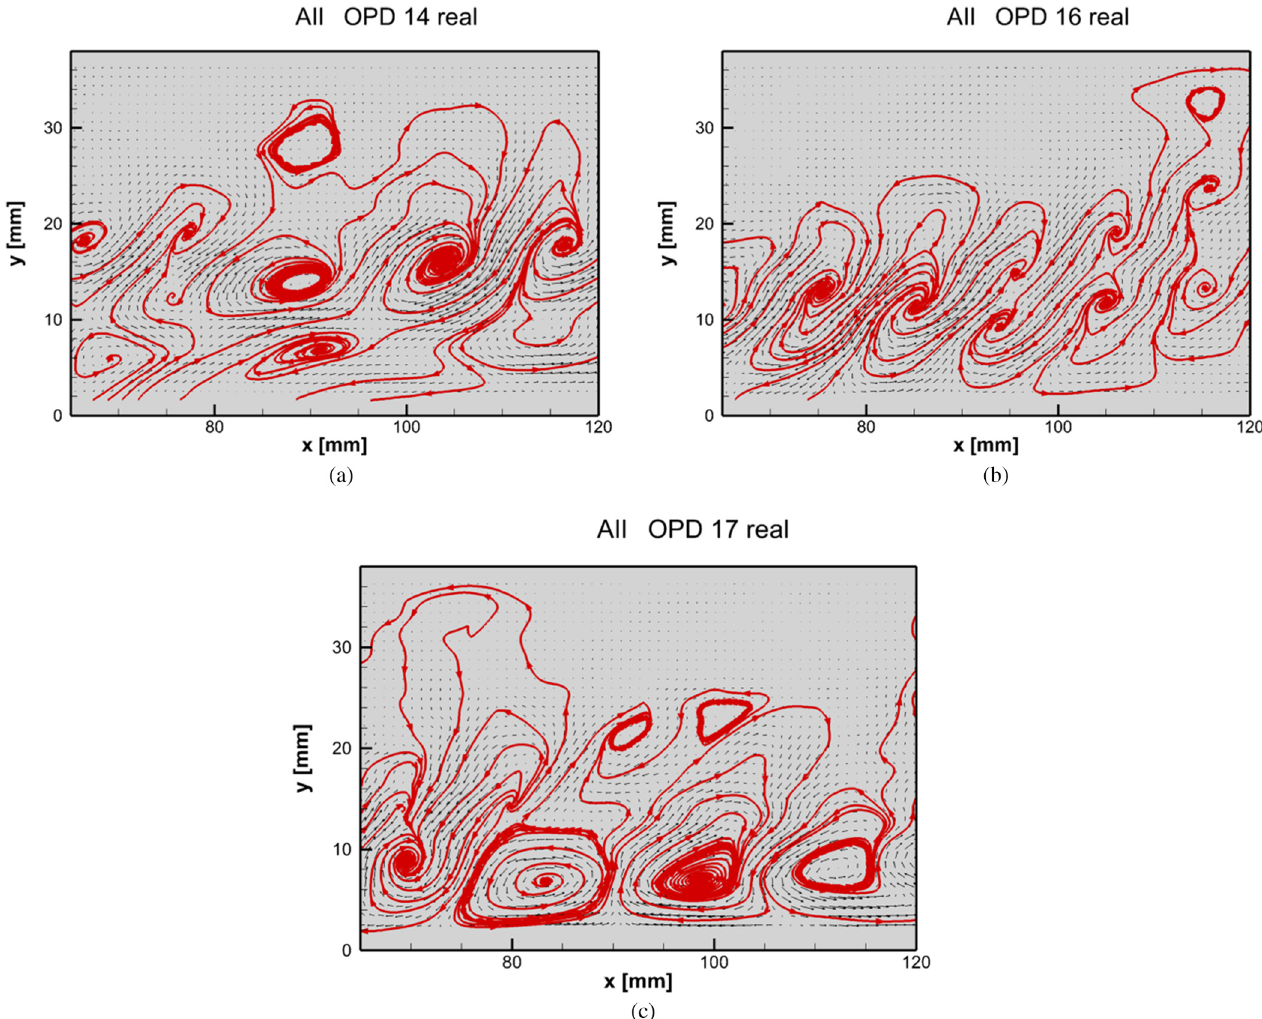
Fig. 15. Topologies of the selected OPD modes in the branch A, zone II, real parts (a) 14, (b) 16 and (c) 17.